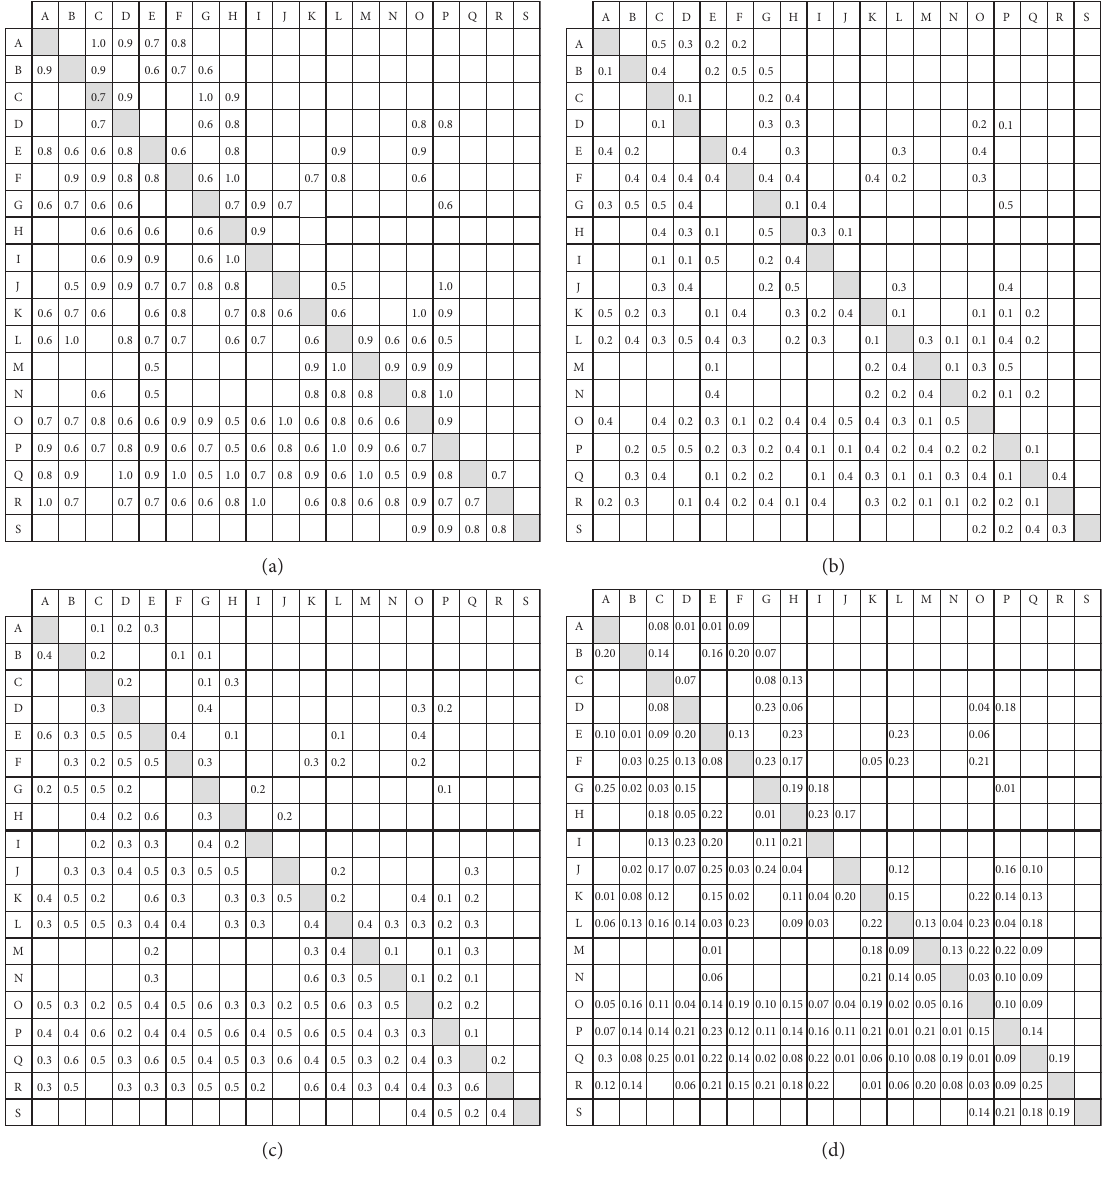
. (b) Matrix S . (c) Matrix RP . (d) Matrix RI 0 0 0 0